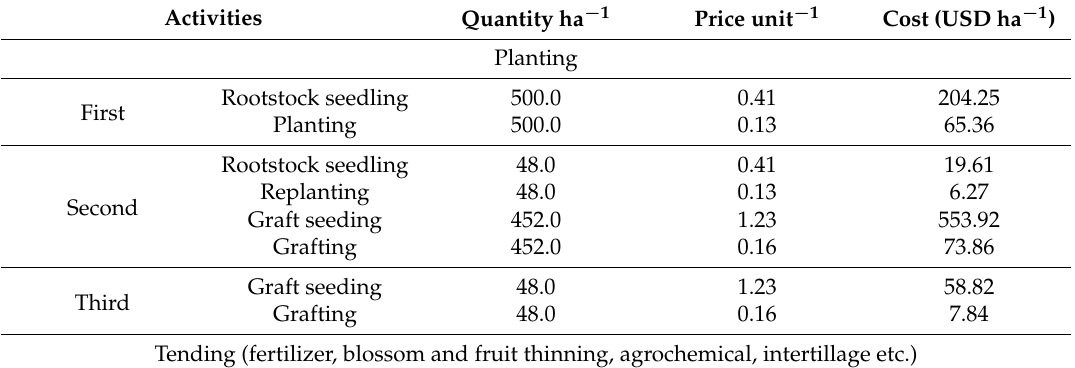
Table 4. Cost structure of apple monoculture system in